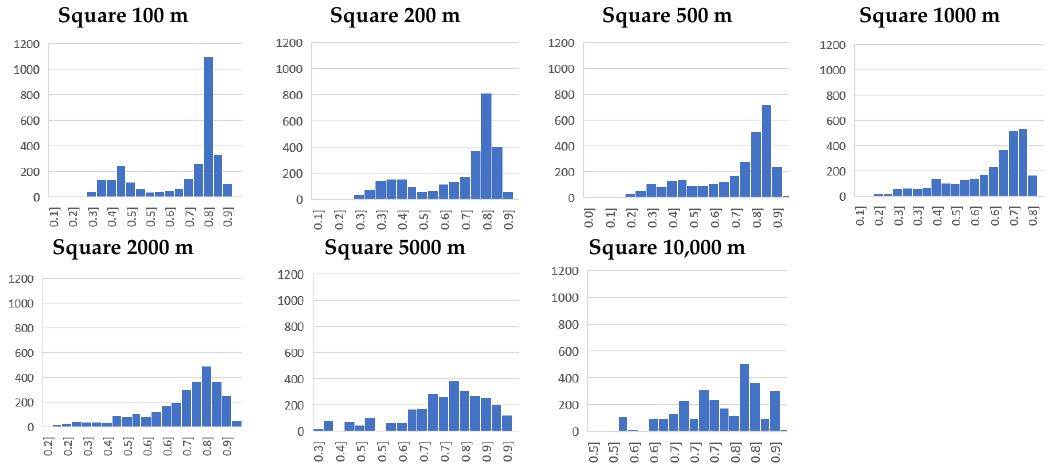
Figure 9. Histogram of the distribution of indices of passability for the analysed cell sizes for the 1000 m control point grid (2942 points).